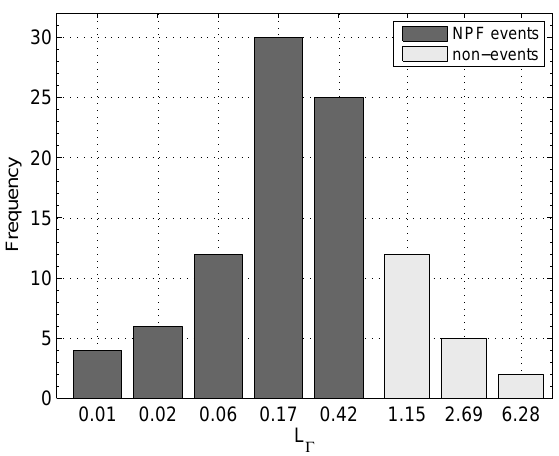
Fig. 4. Histogram of measured L 0 values associated with seventy- seven NPF events and nineteen non-events from the MILAGRO (Tecamac), ANARChE (Atlanta), Boulder, QUEST II (Hyyti¨al¨a), QUEST IV (Hyyti¨al¨a), and EUCAARI (Hyyti¨al¨a) measurement campaigns. L 0 = L 1 /0 1 , where L 1 is the dimensionless cluster scavenging parameter (Eq. (11) and 0 1 is the dimensionless cluster growth parameter (Eq. 14). Values of L 0 are binned on a loga- rithmic scale, ranging from 0.0075–0.66 for NPF events and from 0.76–9.4 for non-events, and are listed for each campaign in Ta- bles 1 and 2,